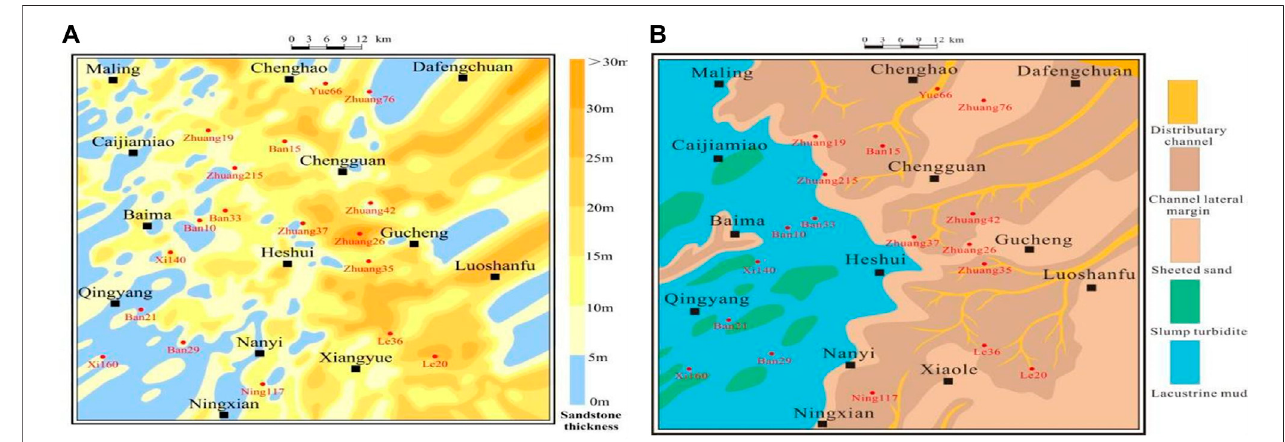
FIGURE 12 | The planar distributions of sand bodies and sedimentary facies are well correlated. (A) Plane distribution diagram of the sand body; (B) Plane distribution map of depositional facies.